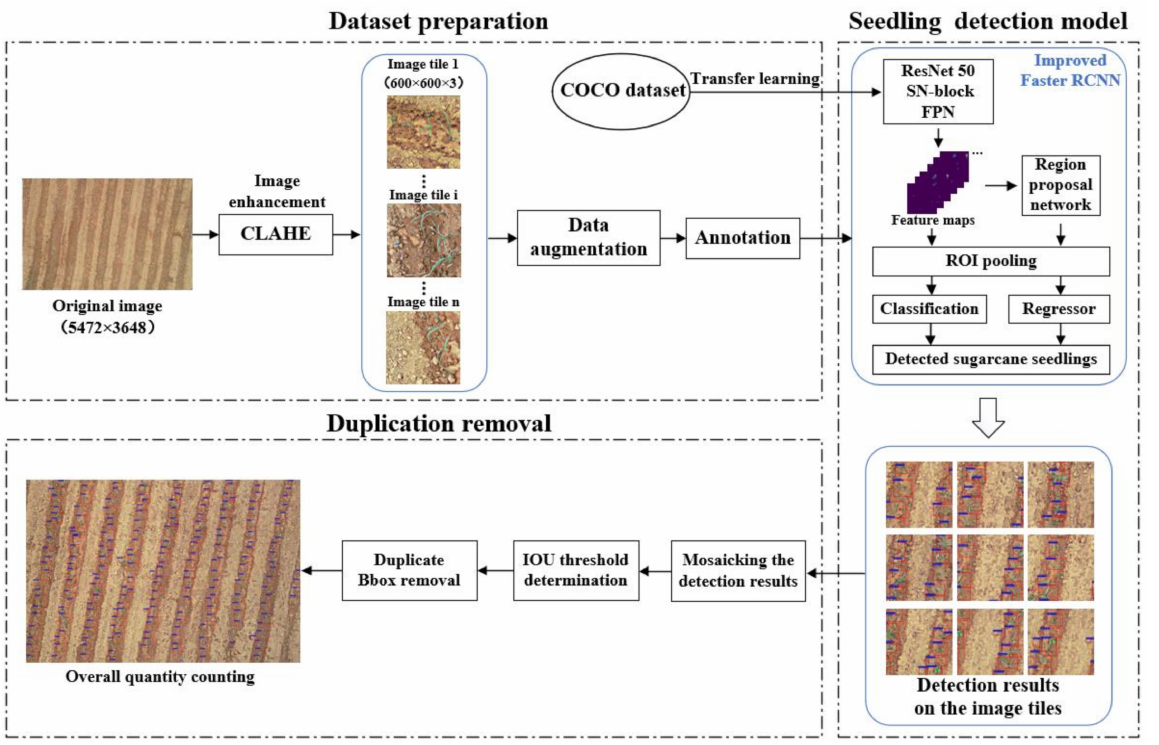
Figure 3. Overall flowchart of the sugarcane seedling detection and counting